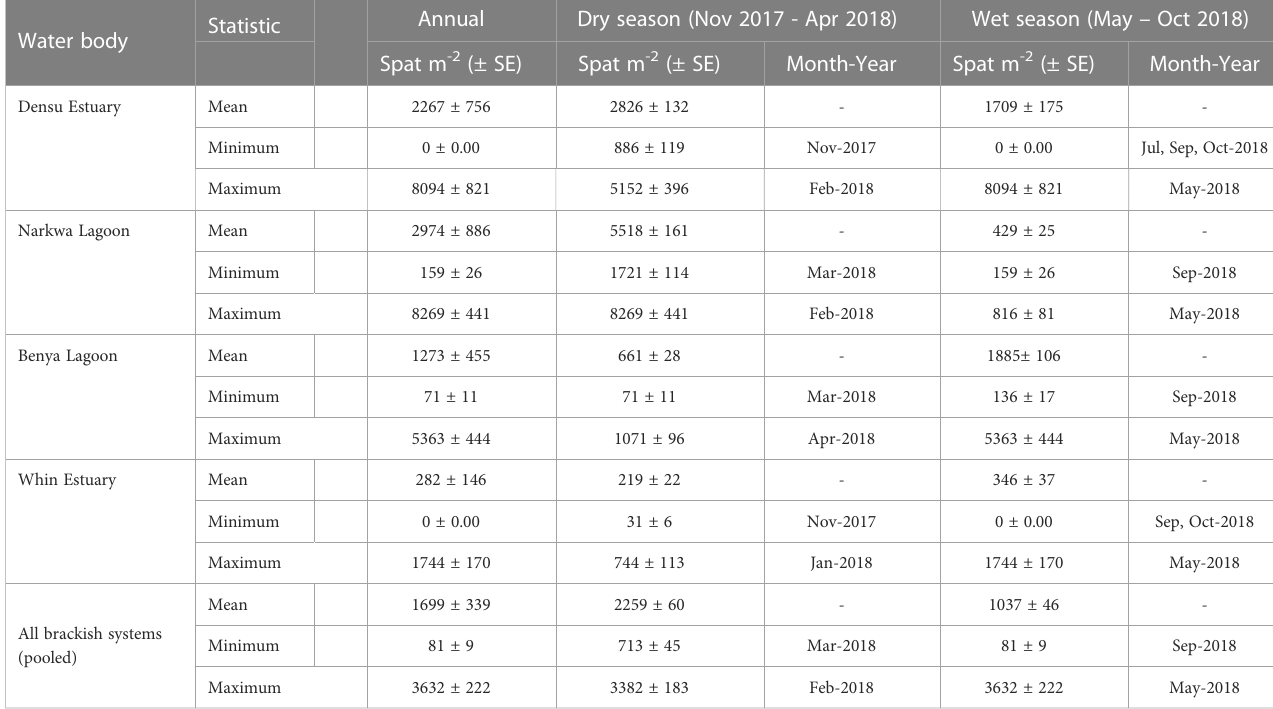
TABLE 2 Annual and seasonal mean, minimum and maximum spatfall (number of spat/m 2 ) in the Densu, Narkwa, Benya and Whin brackish systems pooled from monthly averages.